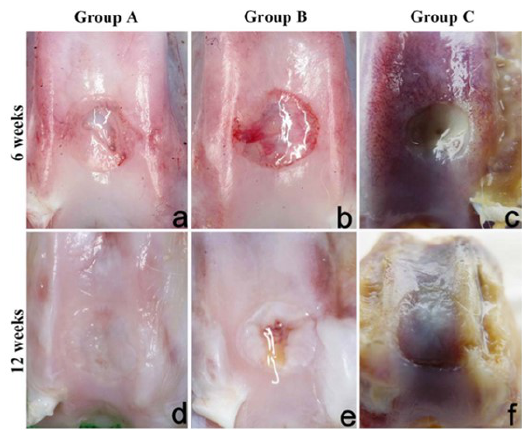
Figure 2. Gross appearance of the knees after implantation in vivo at 6 and 12 weeks. ( a ) At 6 weeks in group A; ( b ) At 6 weeks in group B; ( c ) At 6 weeks in group C; ( d ) At 12 weeks in group A; ( e ) At 12 weeks in group B; ( f ) At 12 weeks in group C. Adapted with permission from ref [32]. Copyright 2015 by John Wiley & Sons, Inc.